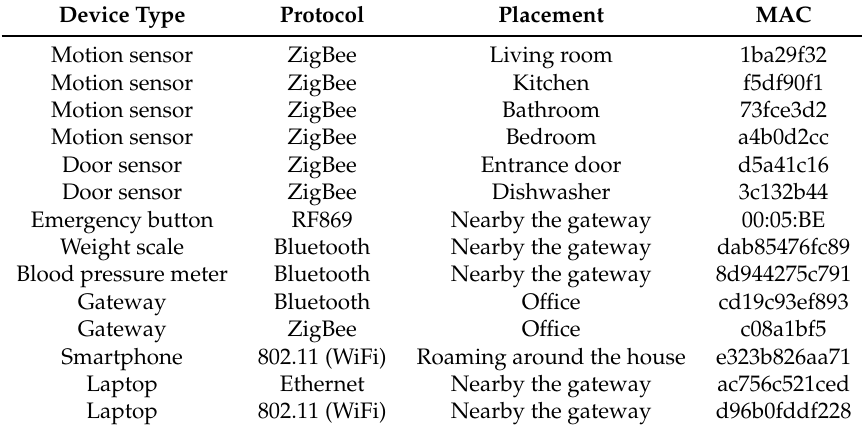
Table 1. Devices deployed in the